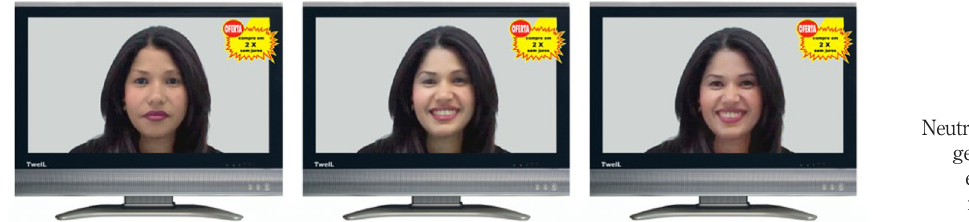
Figure 2. Neutral, false and genuine facial expressions,